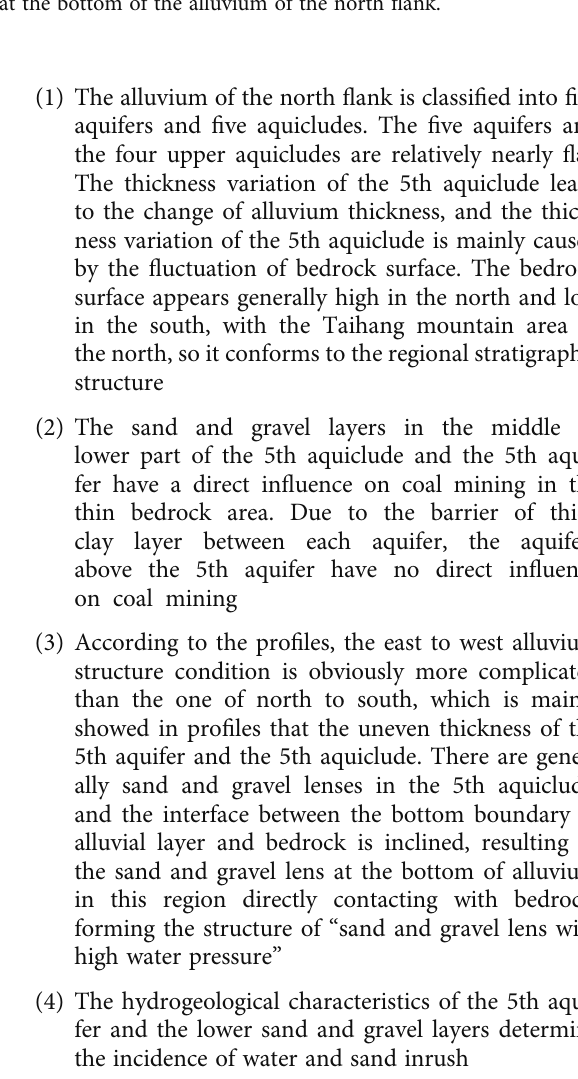
Figure 4: Contour map of the thickness of clay layer at the bottom of the alluvium of the north fl